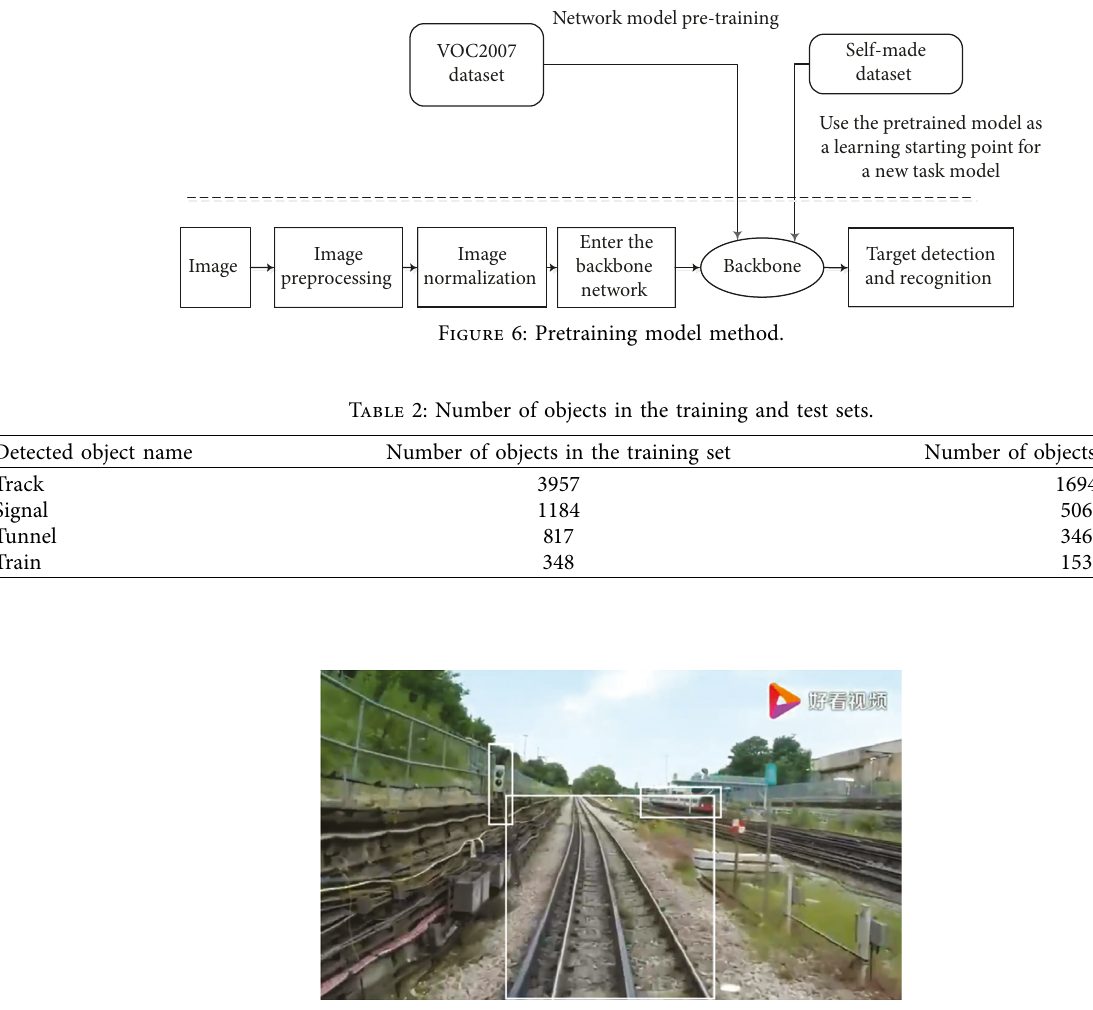
Figure 7: Original